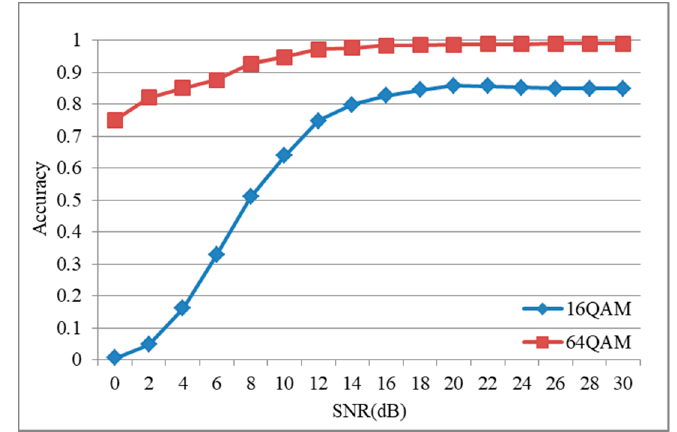
Figure 8. Classification accuracy of each SNR of the real dataset RealSig. The classification method is CMM and the CNN model used is MobileNet_V2.